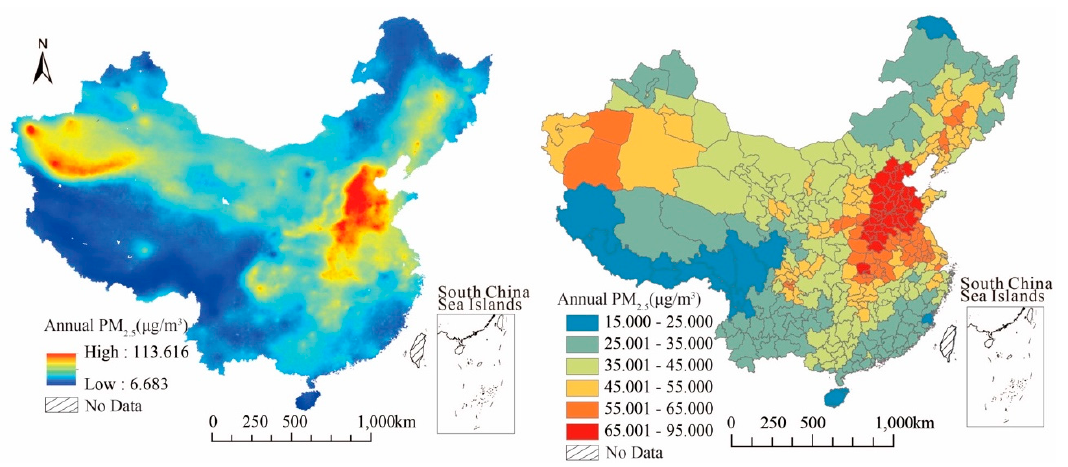
Figure 1. Spatial distribution characteristics of PM 2.5 concentration in 2015. The left figure is remote sensing of PM 2.5 concentration and the right figure is PM 2.5 concentration in city level after using the zonal statistic in ArcGIS (Geographic Information Science).